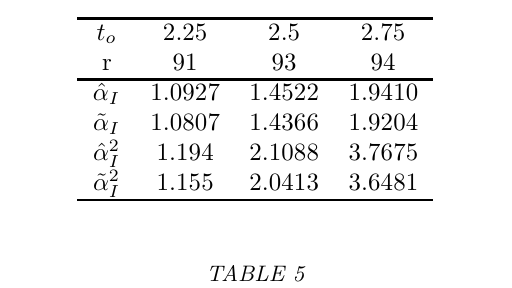
Estimates of powers of α obtained under Type I censoring (p=1,2)